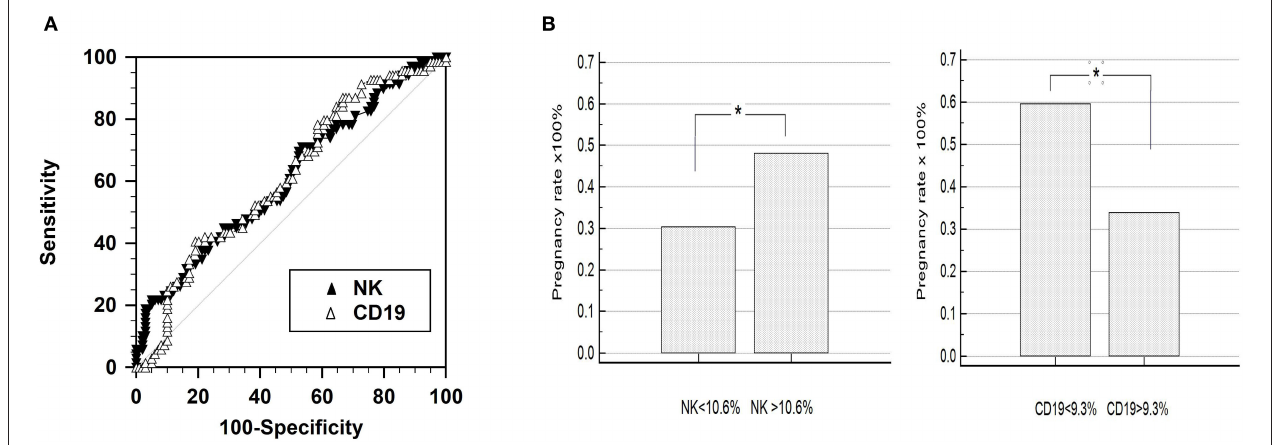
FIGURE 3 | Receiver operating characteristic (ROC) curve analysis of CD56 + CD16 + NK cell percentage. (A) Comparison of the predictive value for pregnancy outcome by means of area under the curve of receiver operating characteristic (ROC AUC ) curve analysis. The percentage of peripheral natural killer (NK; CD56 + CD16 + ) and B (CD19) cells featured similar ROC AUC for ART outcome. (B) Pregnancy outcome of the groups divided by the criteria selected by the ROC curve analysis: 10.6% for the NK cells (CD3-CD56 + CD16 + ) and 9.3% for the B cells (CD19 + ),